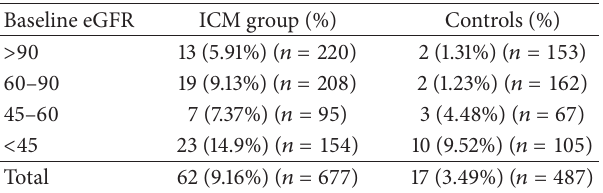
Table 2: Number of patients developing post-CT AKI in the ICM and control groups with varying baseline eGFR. (eGFR in mL/min/1.73 m 2